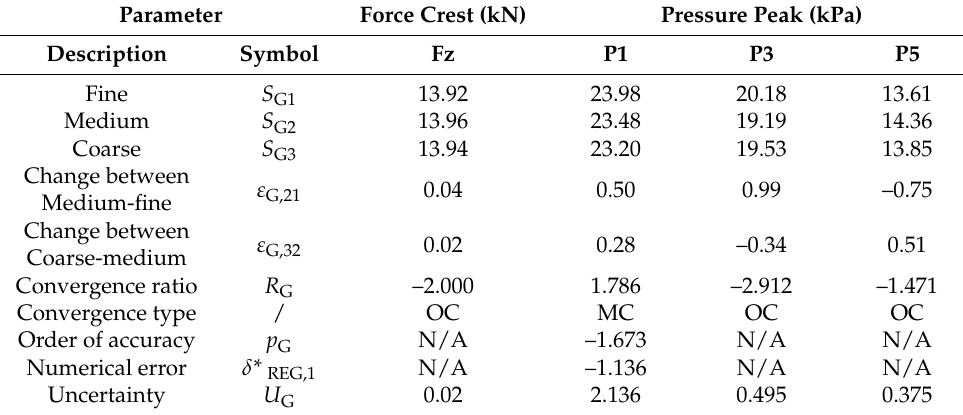
Table 6. Convergence study for slamming loads by different CFD grid